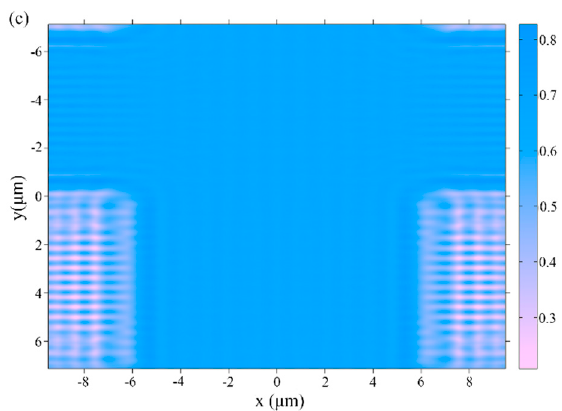
Figure 10. The dyeing diagram of letter T. ( a ) The dyeing diagram of letter T with D = 190 nm and p = 290 nm for every nanostructure. ( b ) The dyeing diagram of letter T with D = 115 nm and p = 290 nm for every nanostructure. ( c ) The dyeing diagram of letter T with D = 100 nm and p = 190 nm for every nanostructure.